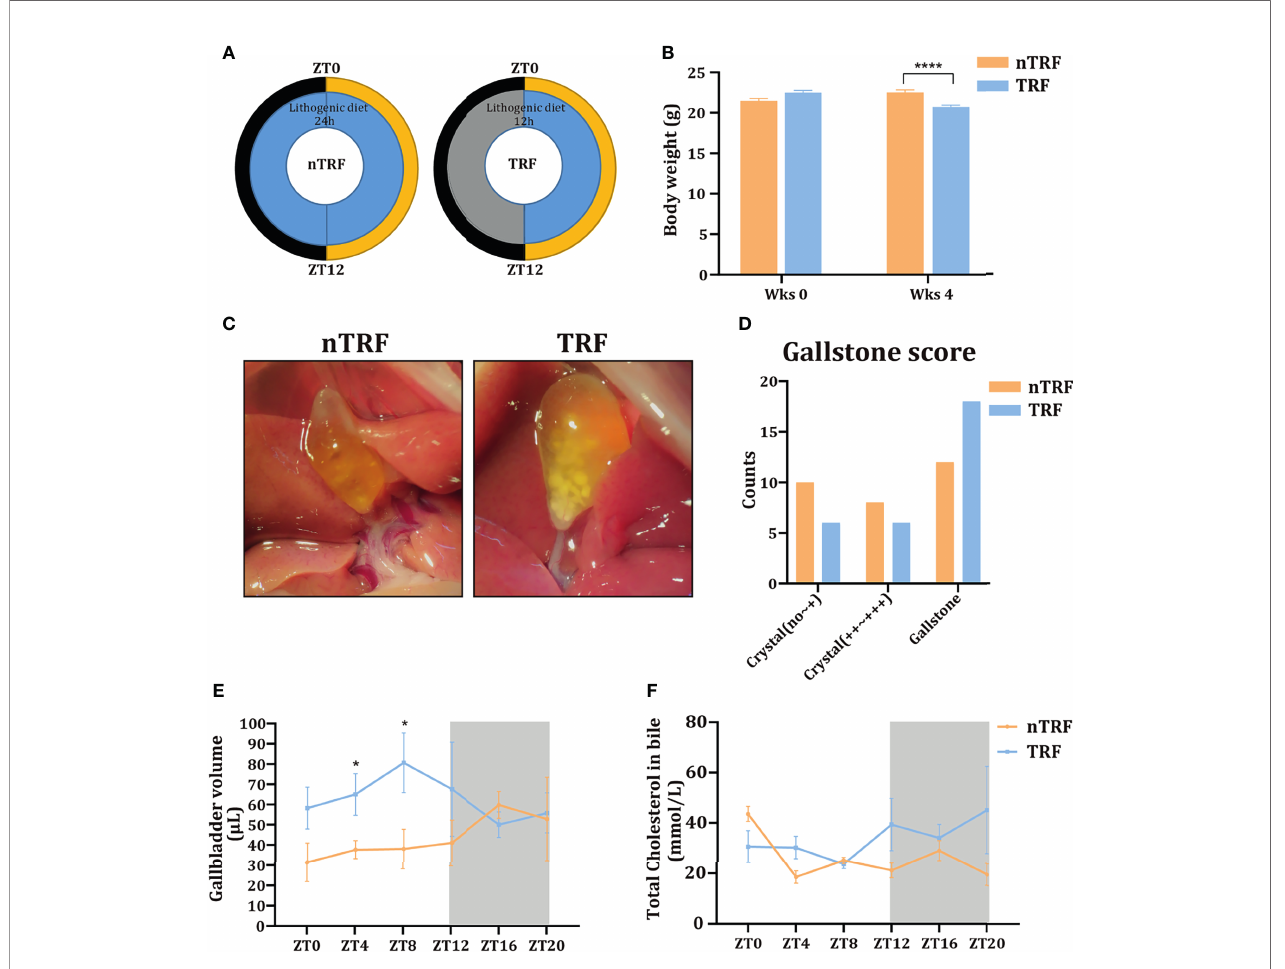
FIGURE 1 | Time-restricted lithogenic diet-feeding (TRF) promotes gallstone formation. (A) Schematic diagram of the animal experiment. (B) Body masses of the mice at the beginning and the end of 4 weeks of feeding. (C) Appearance of the gallbladder in non-TRF (left) and TRF (right) mice. (D) The overall evaluation of gallstone. (E) Gallbladder volume of mice in the TRF and non-TRF group at various Zeitgeber times (ZT). (F) Biliary cholesterol concentrations at various ZT. Data are expressed as mean ± SEM (n = 5 mice/group at each time point). “ * ” means p < 0.05, “ **** ” means p <